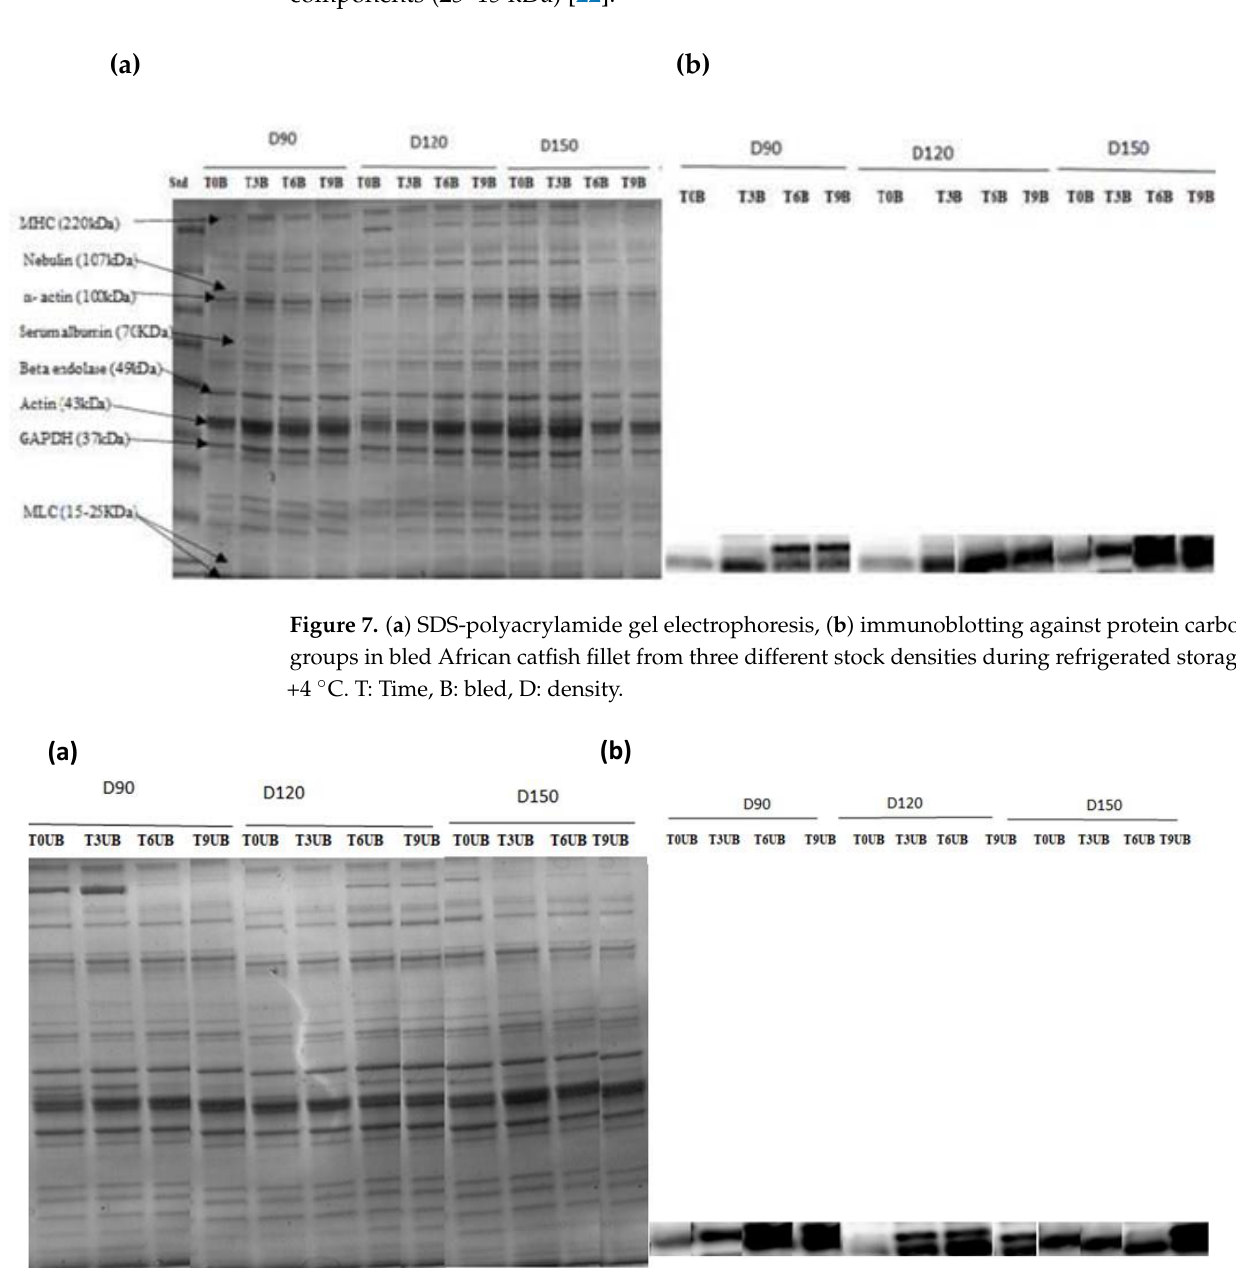
Figure 8. ( a ) SDS-polyacrylamide gel electrophoresis, ( b ) immunoblotting against protein carbonyl groups in bled African catfish fillet from three different stock densities during refrigerated storage at +4 °C. T: Time, B: bled, D: density